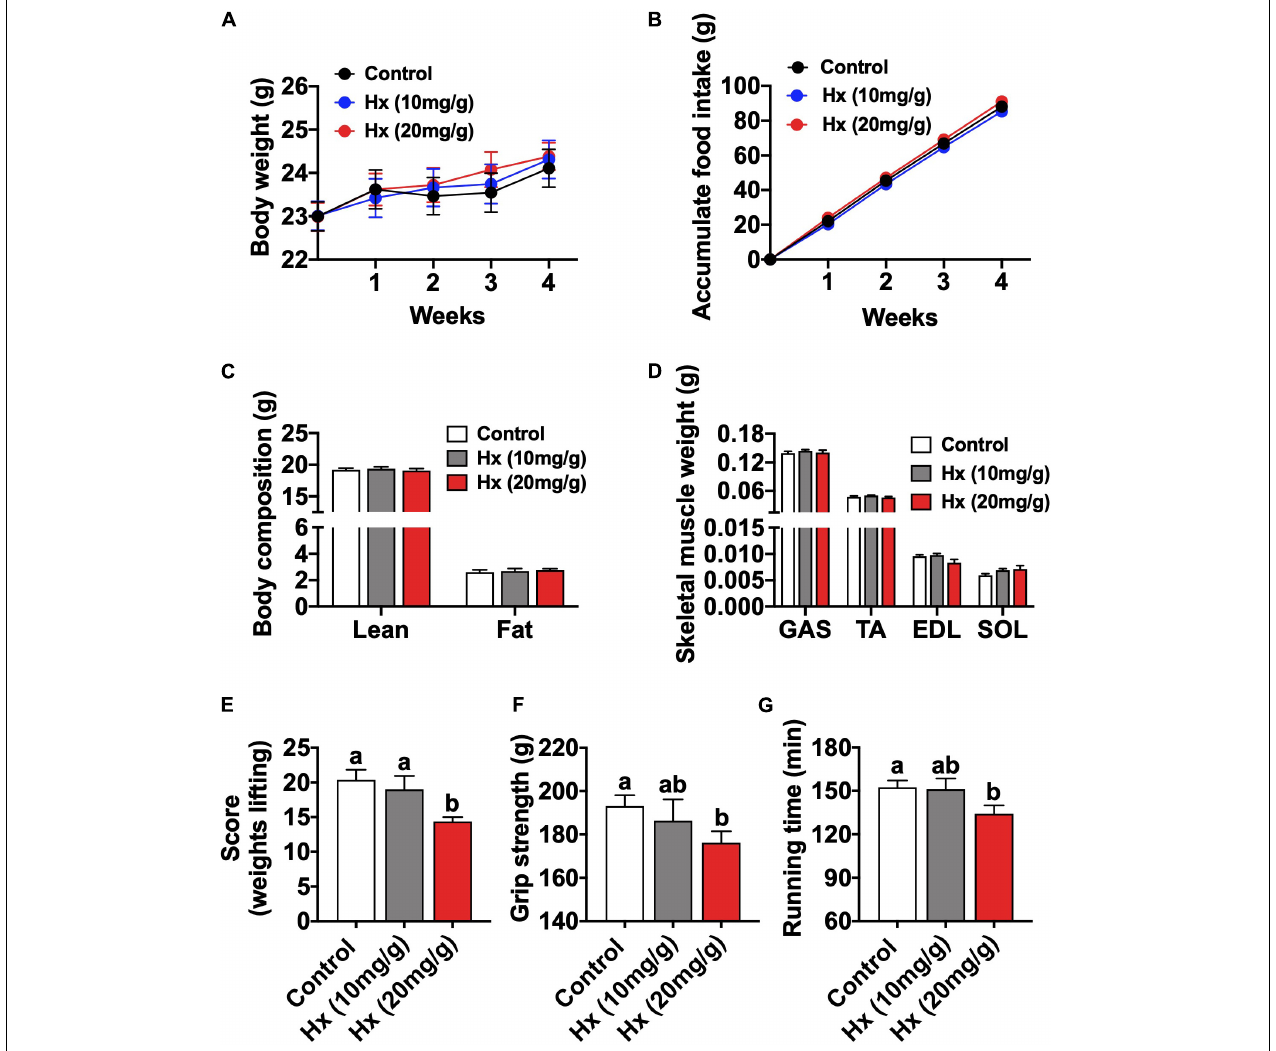
FIGURE 1 | Chronic Hx-treated induces muscular fatigue. (A) Body weight after 4 weeks Hx treatment ( n = 8 mice per group). (B) Cumulative food intake after 4 weeks Hx treatment ( n = 8 mice per group). (C) Body composition of mice after 4 weeks Hx treatment ( n = 8 mice per group). (D) Skeletal muscle weight (GAS; tibialis anterior, TA; soleus, SOL; and extensor digitorum longus, EDL) ( n = 8 mice per group). (E) Weights lifting score after Hx treatment ( n = 8 mice per group). (F) Grip strength after Hx treatment ( n = 8 mice per group). (G) Treadmill running time after Hx treatment ( n = 8 mice per group). Values are presented as means ± SEM, different letters between bars mean P ≤ 0.05 in one-way ANOVA analysis followed by post hoc Tukey’s